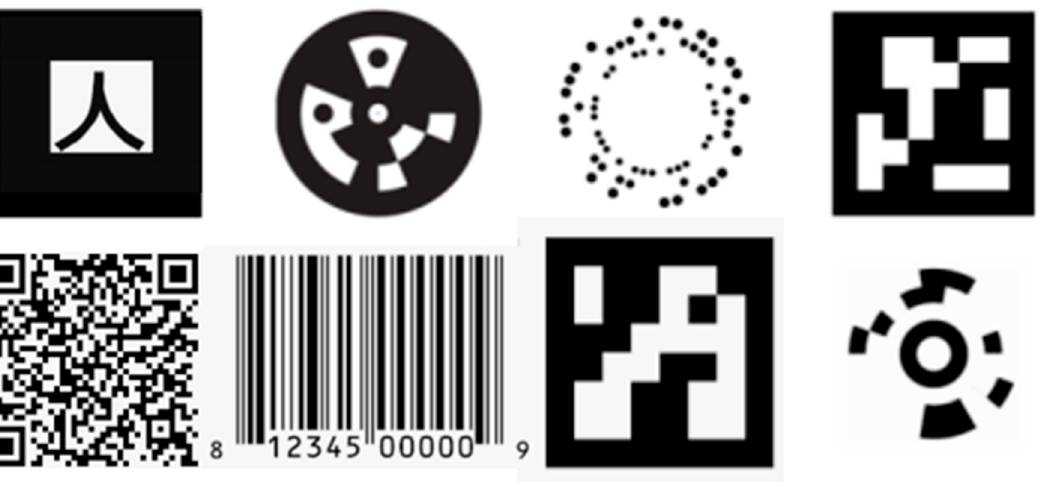
Figure 2. Eight existing marker systems. Top, from left to right: ARToolKit, Circular Data Matrix, RuneTag, ARToolKit Plus. Bottom, from left to right: QR code, barcode, ArUco, Cantag.